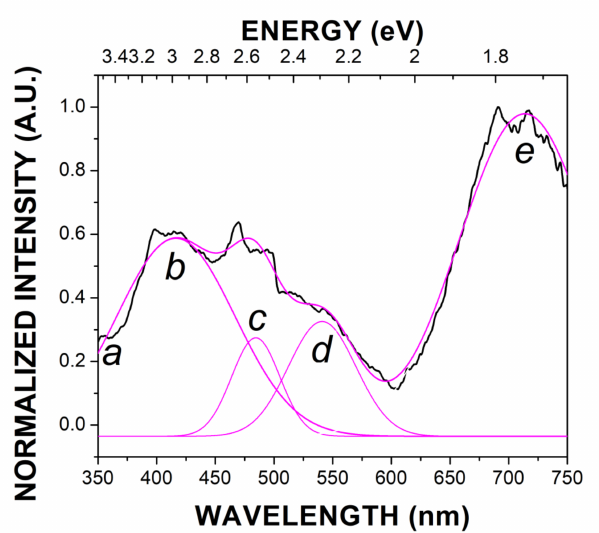
Figure 7. Photoluminescence spectrum for the Mg-doped GaN films deposited by radio-frequency magnetron